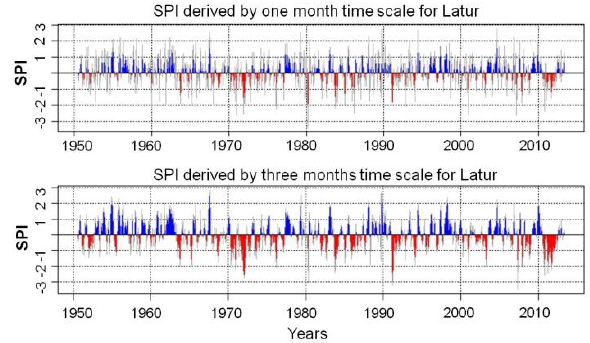
Figure 5. SPI calculated for one and three month time scales for Latur district.